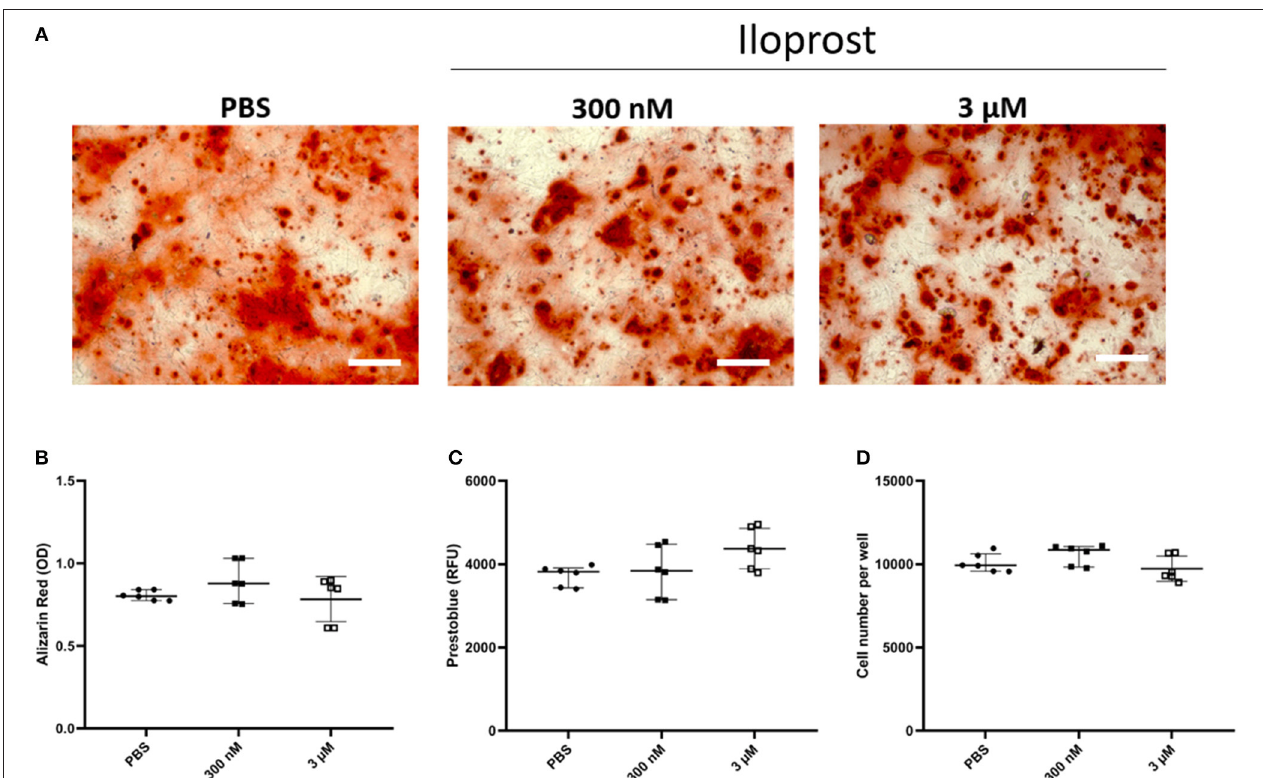
FIGURE 5 | Effect of Iloprost on mineralization capacity of osteogenically induced MSCs. Monolayers of MSCs were stained with Alizarin Red to visualize the formation of mineralized matrix. (A,B) Representative images of the Alizarin Red staining of cultured MSCs with osteoinductive media after 14 days of cultivation. Different concentrations of Iloprost were supplemented to the osteoinductive media (300nM and 3 µ M, respectively) (A) . Quantification of the Alizarin Red staining (B) . The metabolic activity of the cultured MSCs was measured by Prestoblue (C) . Determination of the cell number of the cultured MSCs under the different stimuli (D) . Scale bars: 200 µ m; n = 6.